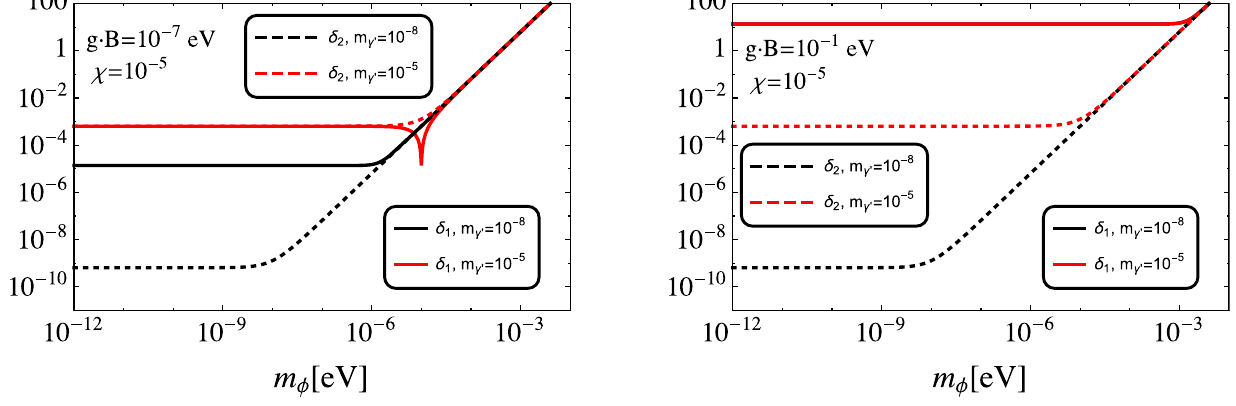
Fig. 1 The oscillation angles δ 1 = (cid:13) L and δ 2 = (cid:12) L (defined in Eq. (18)) as a function of the ALP mass, m φ for two different masses of HP. Plot of the left considers a ’small coupling’ to the magnetic field, g × B = 10 − 7 eV, while the plot of the right considers a ’strong cou- pling’ with the magnetic field, g × B = 10 − 1 eV. The magnitude of the